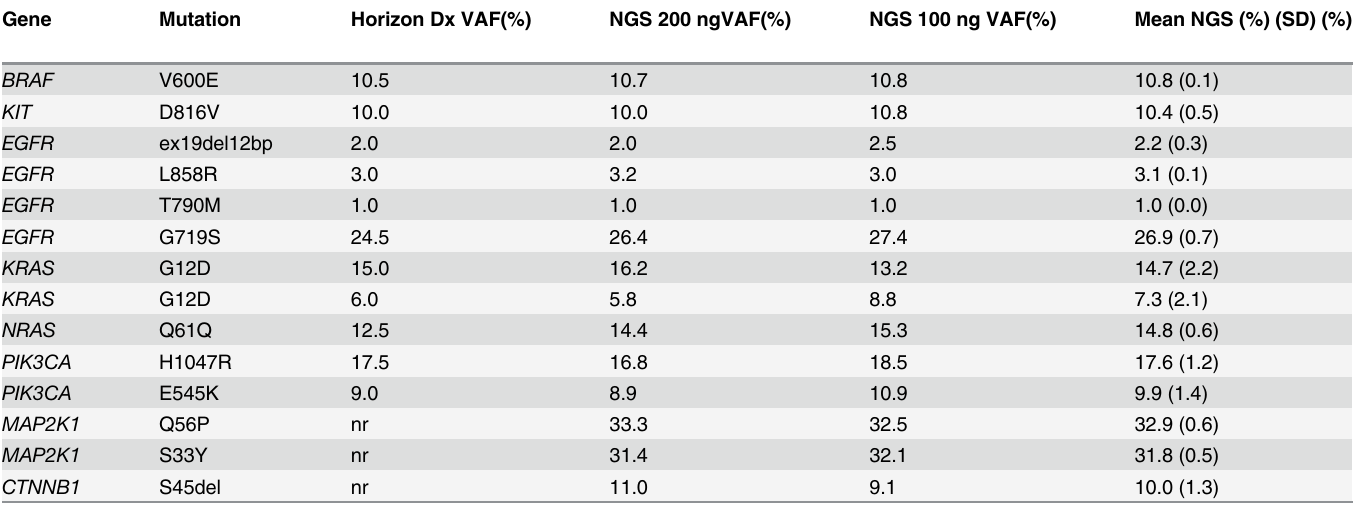
Table 1. The accuracy of the NGS workflow was checked with the Horizon Quantitation multiplex reference that contains 11 mutations at known variant allele frequencies (VAF). NGS data are provided for DNA start amounts of 100 ng and 200 ng. Mean and standard deviations (SD) are given as well. del: deletion; nr: not